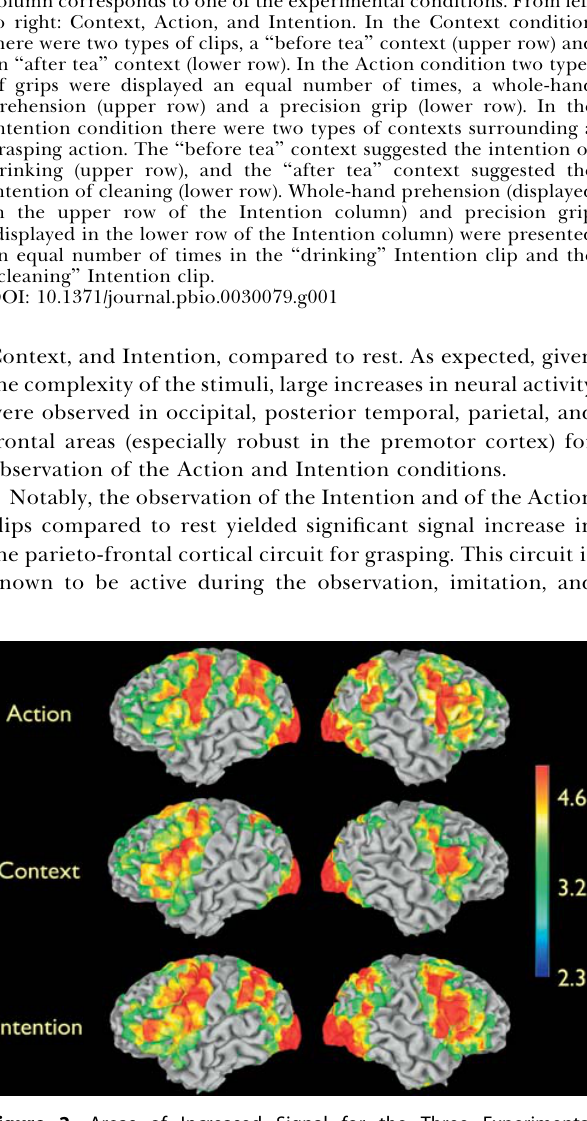
Figure 2. Areas of Increased Signal for the Three Experimental Conditions Threshold of Z = 2.3 at voxel level and a cluster level corrected for the whole brain at p , 0.05. DOI: